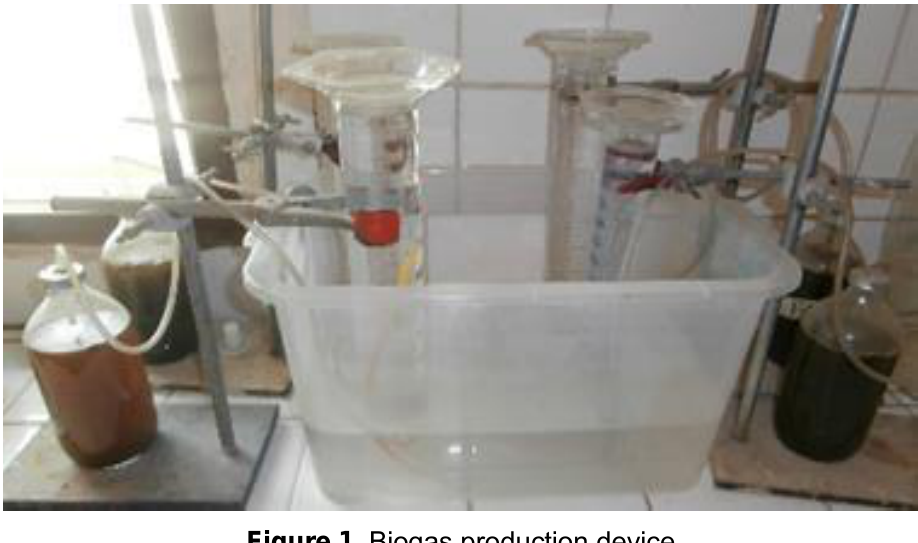
Figure 1 . Biogas production